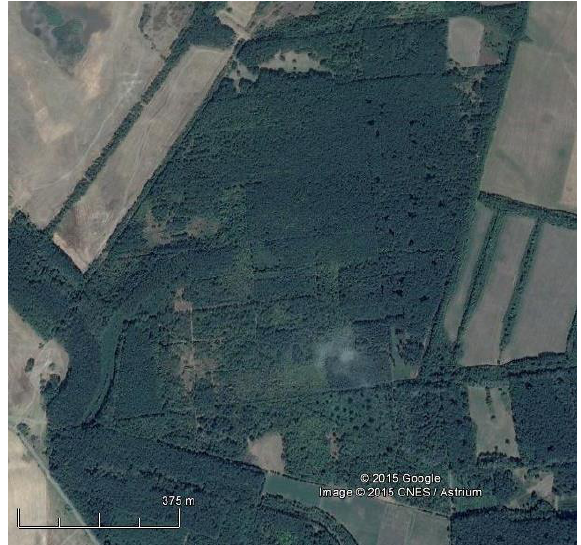
Figure 1. Satellite image overview of the study area. ©